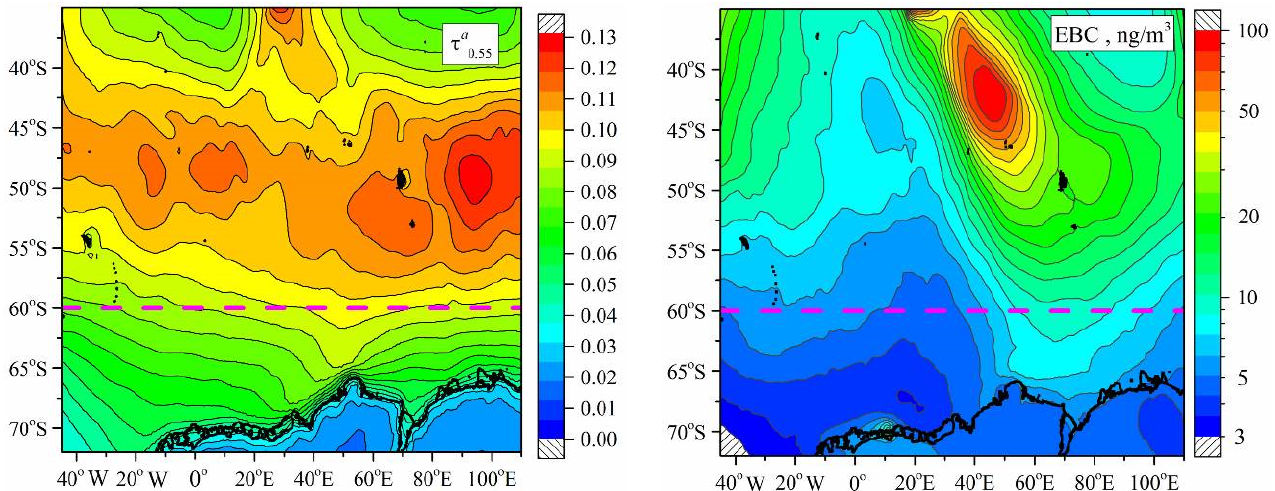
Figure 6. Average spatial distribution of AOD and black carbon concentrations according to MERRA-2 reanalysis data. 2 reanalysis data.